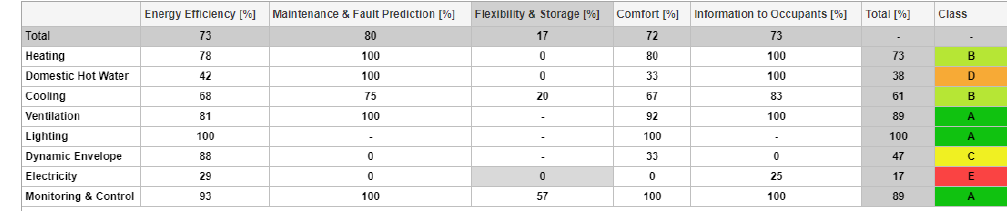
Figure 8. IBACSA performance matrix for Case B with domains and criteria impacts.